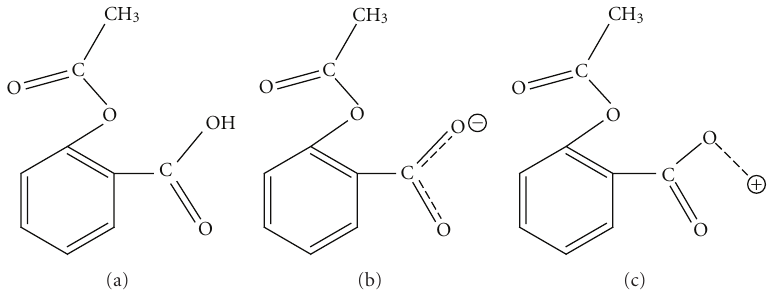
Figure 1: ASA molecule (a), ASA anion (b), and ASA chelation of cation (c).